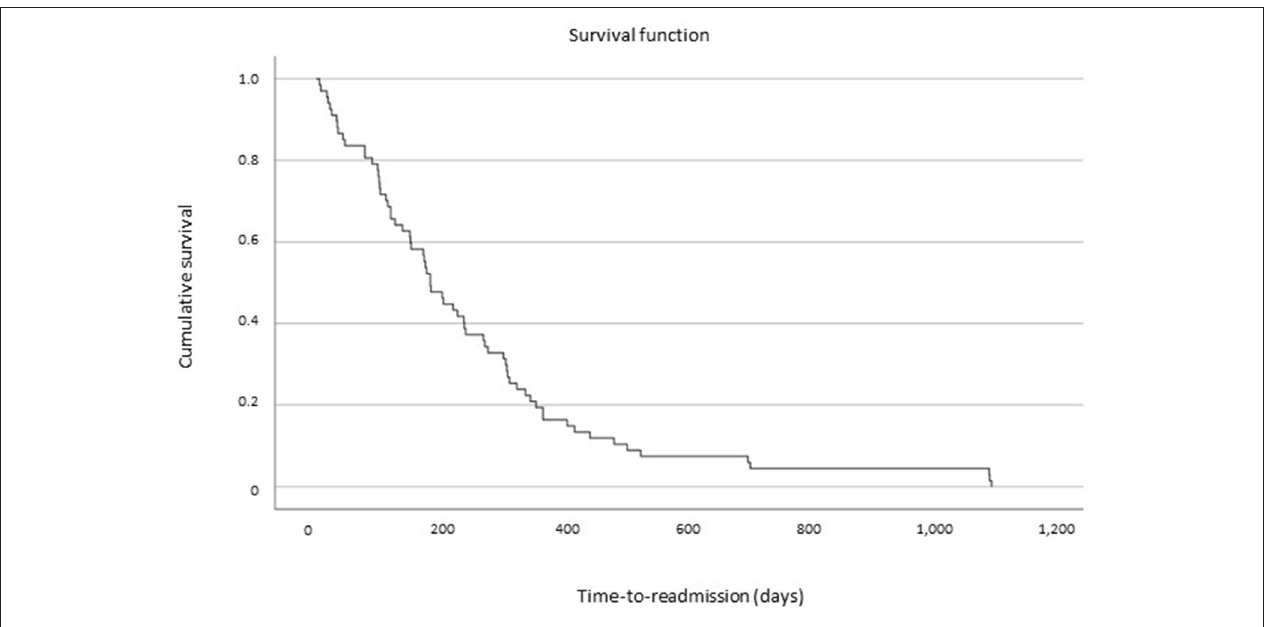
FIGURE 1 | Survival analysis after baseline discharge of time-to-readmission for patients with anorexia nervosa.